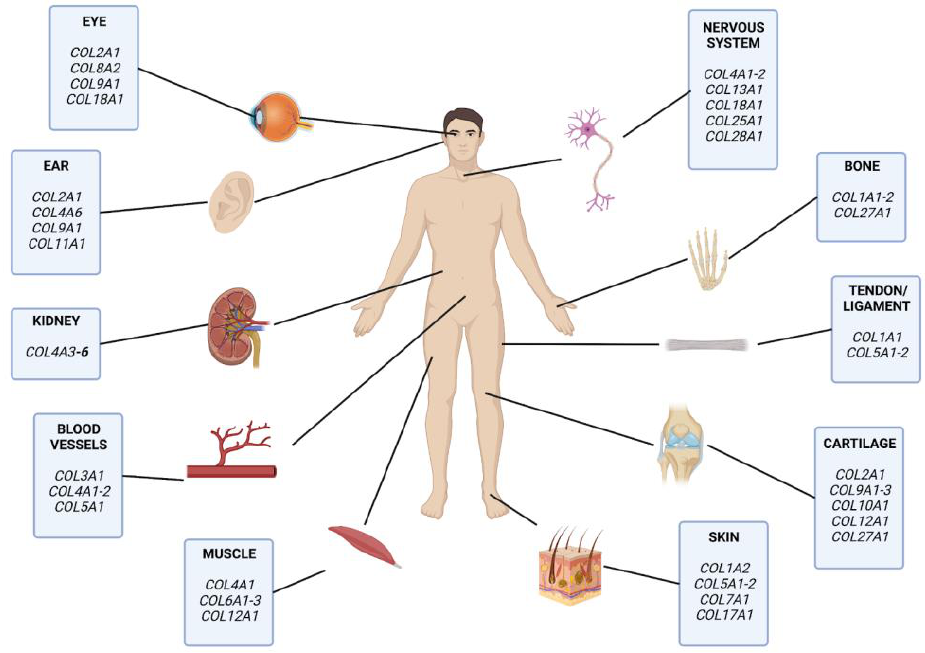
Figure 1. Collagens in Human Tissues. Different types of collagen proteins experience localized expression in various tissue types. For example, COL2A1 is expressed in tissues with substantial components of cartilaginous fibers.